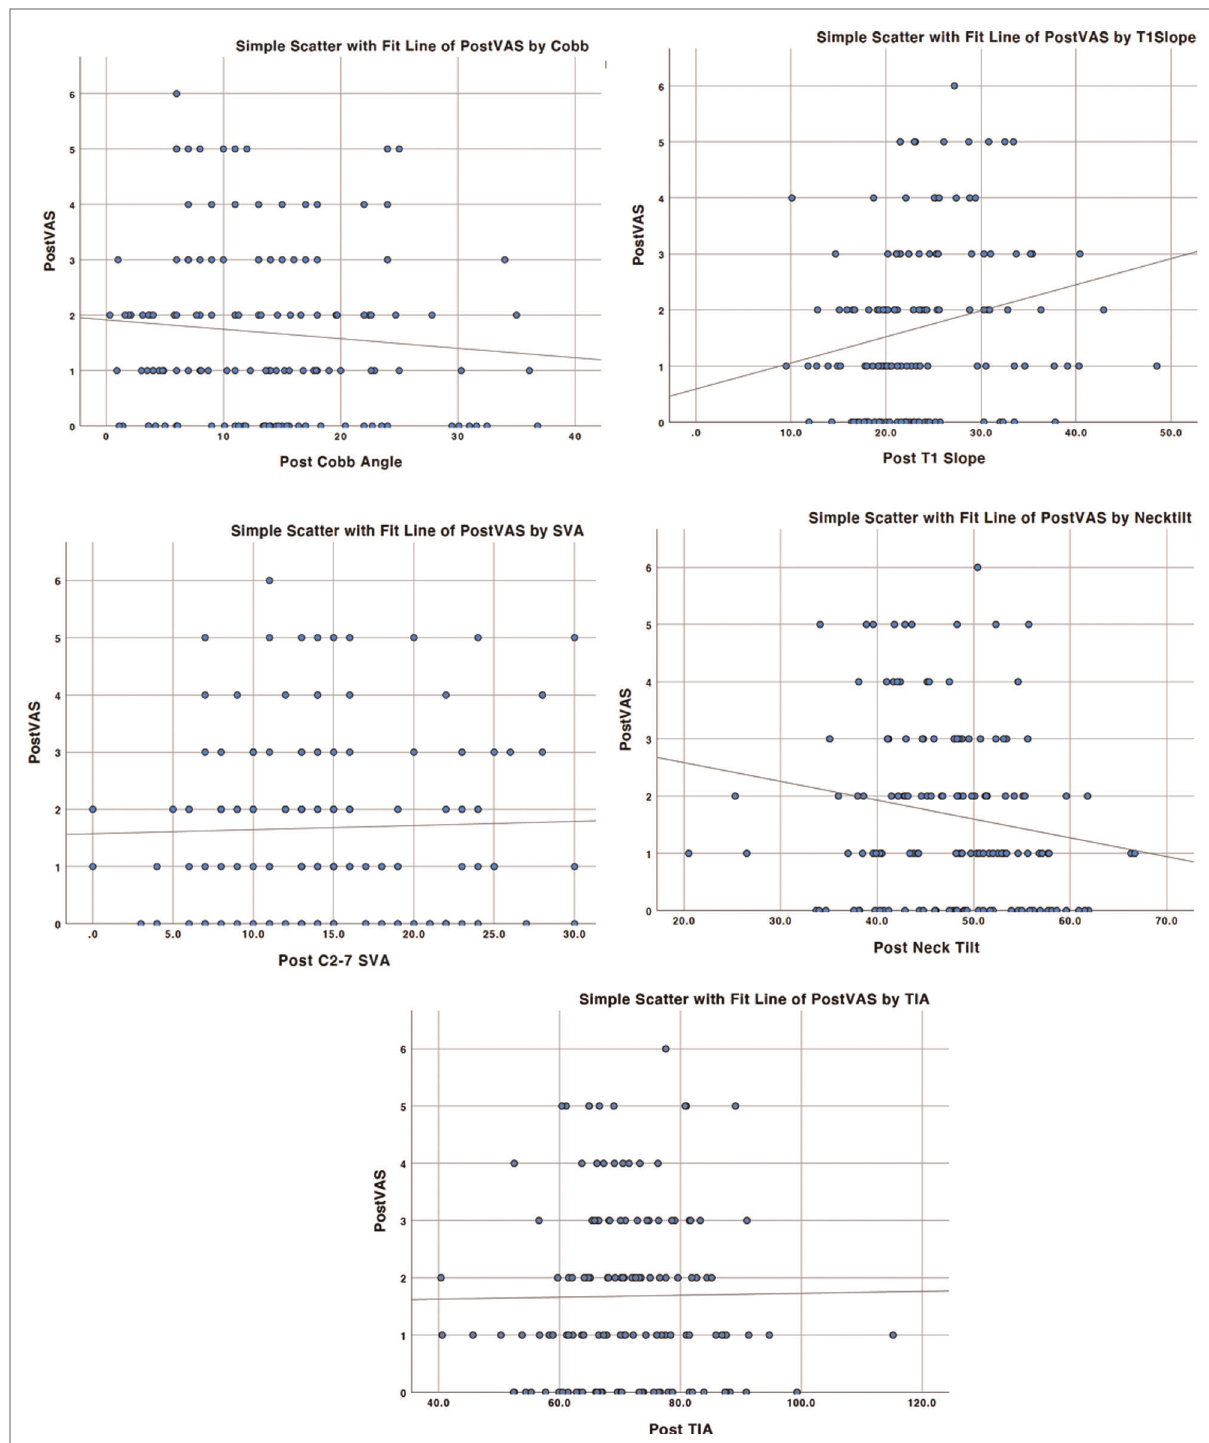
FIGURE 4 Simple scatter with fi t line of postoperative VAS by Cobb angle, T1 slope, C2 – 7 SVA, neck tilt, and TIA, with p values all more than